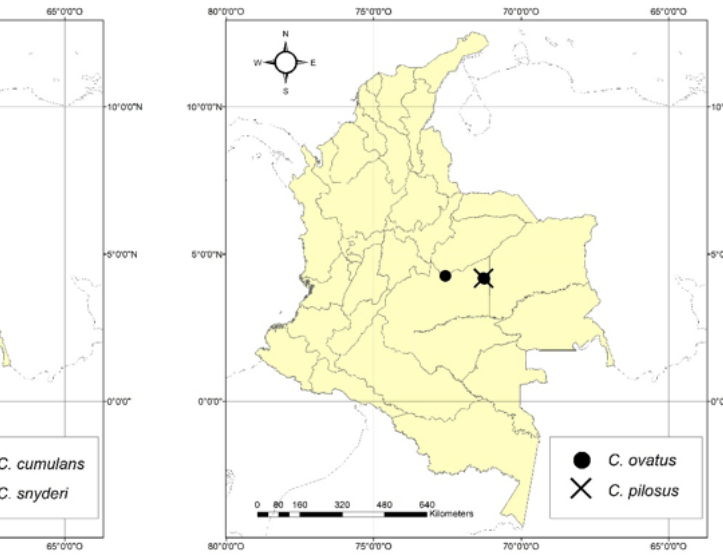
Figure 2. Distribution map of Cornitermes pilosus and Cornitermes ovatus .